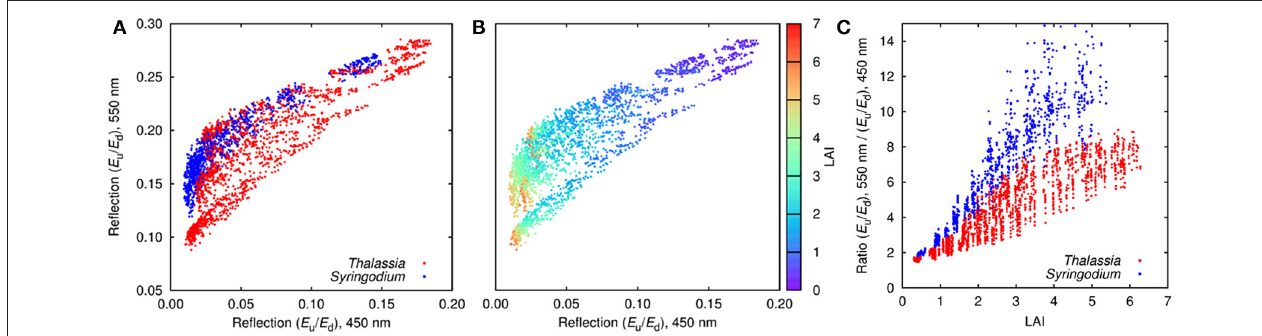
FIGURE 5 | Distribution of top of canopy (TOC) reflectance for all modeled Thalassia and Syringodium canopies with 26 ◦ solar zenith angle, in two band space: 450 and 550nm. (A) Distribution by species, (B) distribution color coded by LAI, (C) band ratio of reflectance at 550–450nm, as a function of LAI. Note that all points are plotted in a random order so the dominance of a color in particular area does not arise simply because other points are obscured.